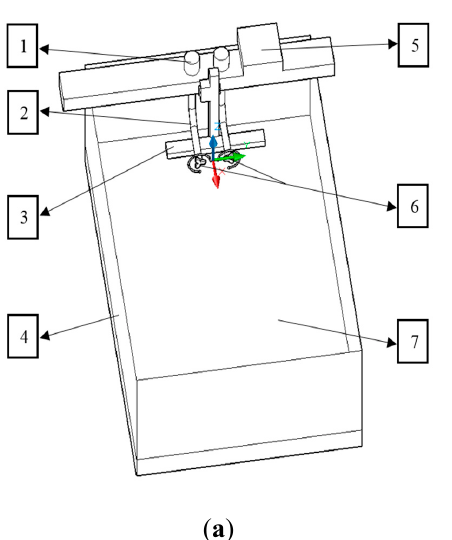
Figure 1. Experimental tank with twin propeller system. ( a ) schematic diagram; ( b ) experimental device (1) Geared motor; (2) Powertrain to transfer toque force in 90 degree; (3) Adjustable propeller distance holder; (4) Water tank (1.2 m × 0.8 m × 0.45 m); (5) Transformer and speed switch; (6) Twin-propeller; and, (7) Sandbed.